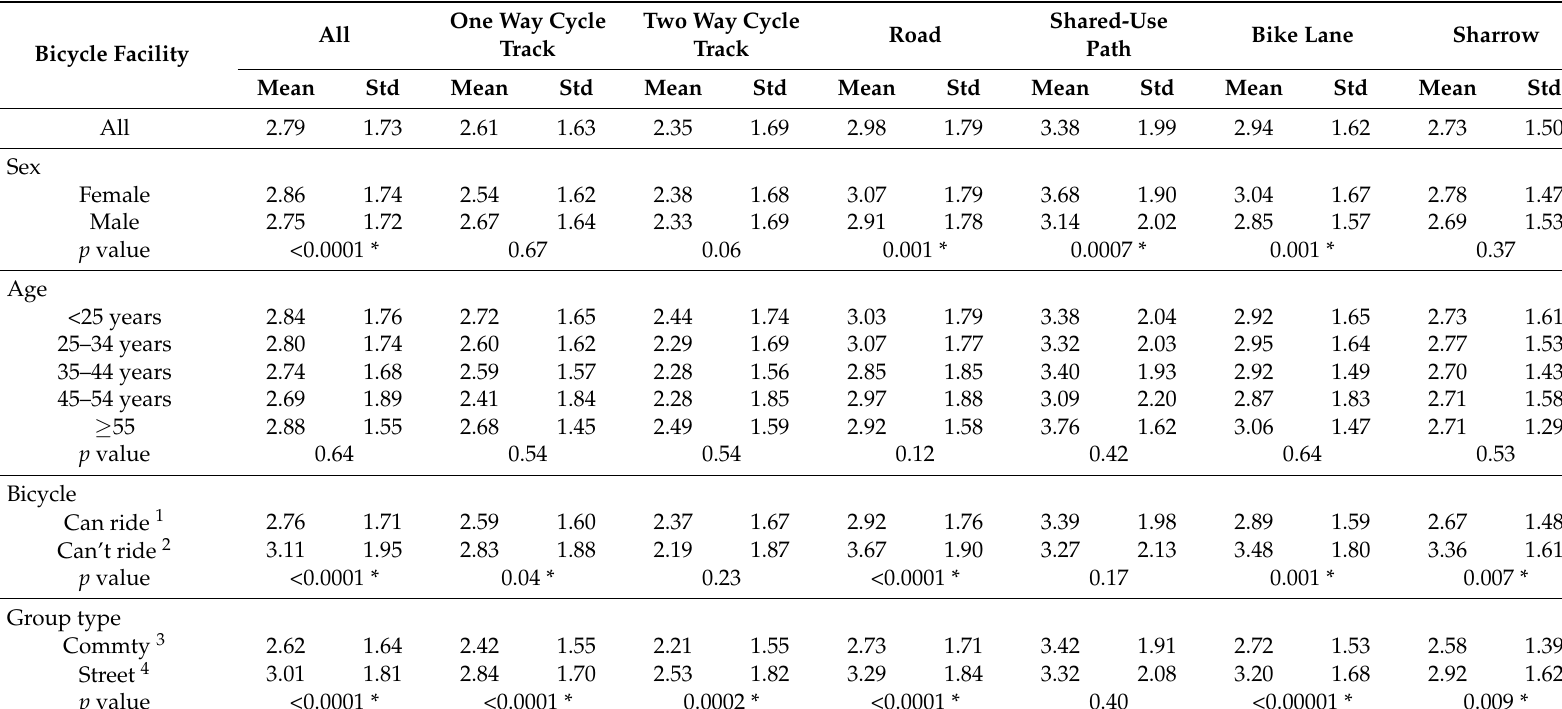
Table 3. Summary statistics for perceptions of crime for each of the six bicycle facility types, stratified by sex, age, bicycle, and group type.